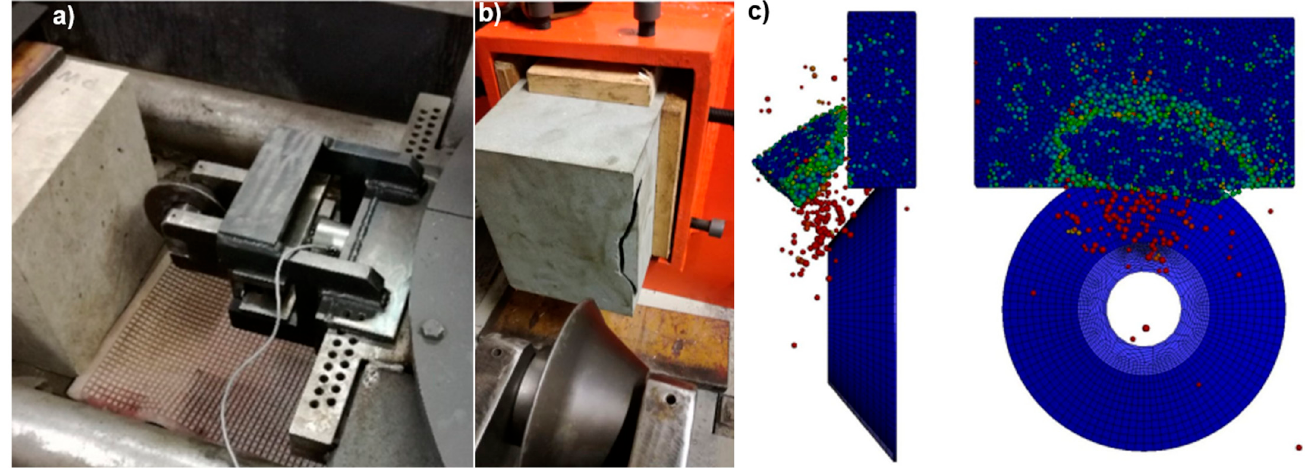
Figure 7. Laboratory and DEM tests of the process of chipping the face with a disc tool [38–40]: ( a ). test bench with rock and disc, ( b ). chip after test, ( c ). DEM results (top and side view).